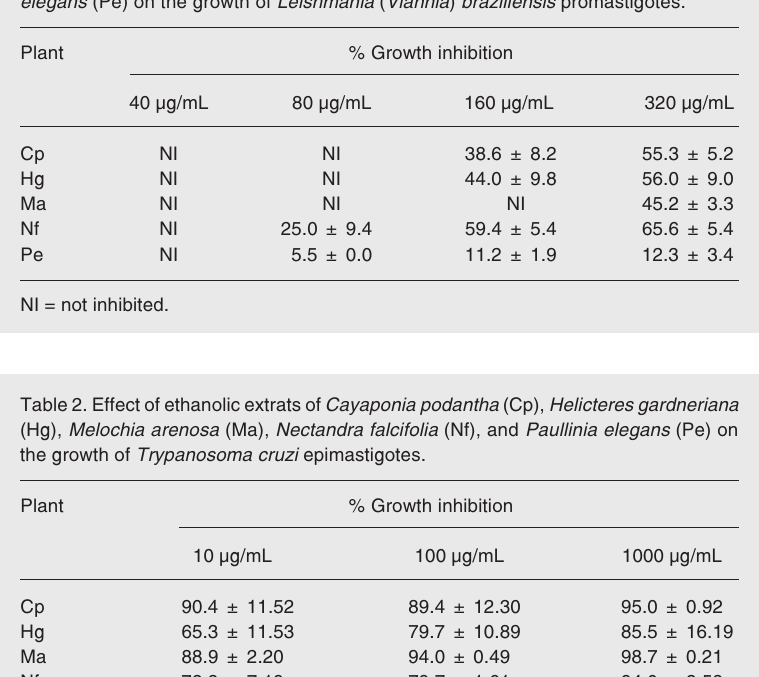
Table 1. Effect of ethanolic extracts of Cayaponia podantha (Cp), Helicteres gardneriana (Hg), Melochia arenosa (Ma), Nectandra falcifolia (Nf), and Paullinia elegans (Pe) on the growth of Leishmania ( Viannia ) braziliensis promastigotes. Plant